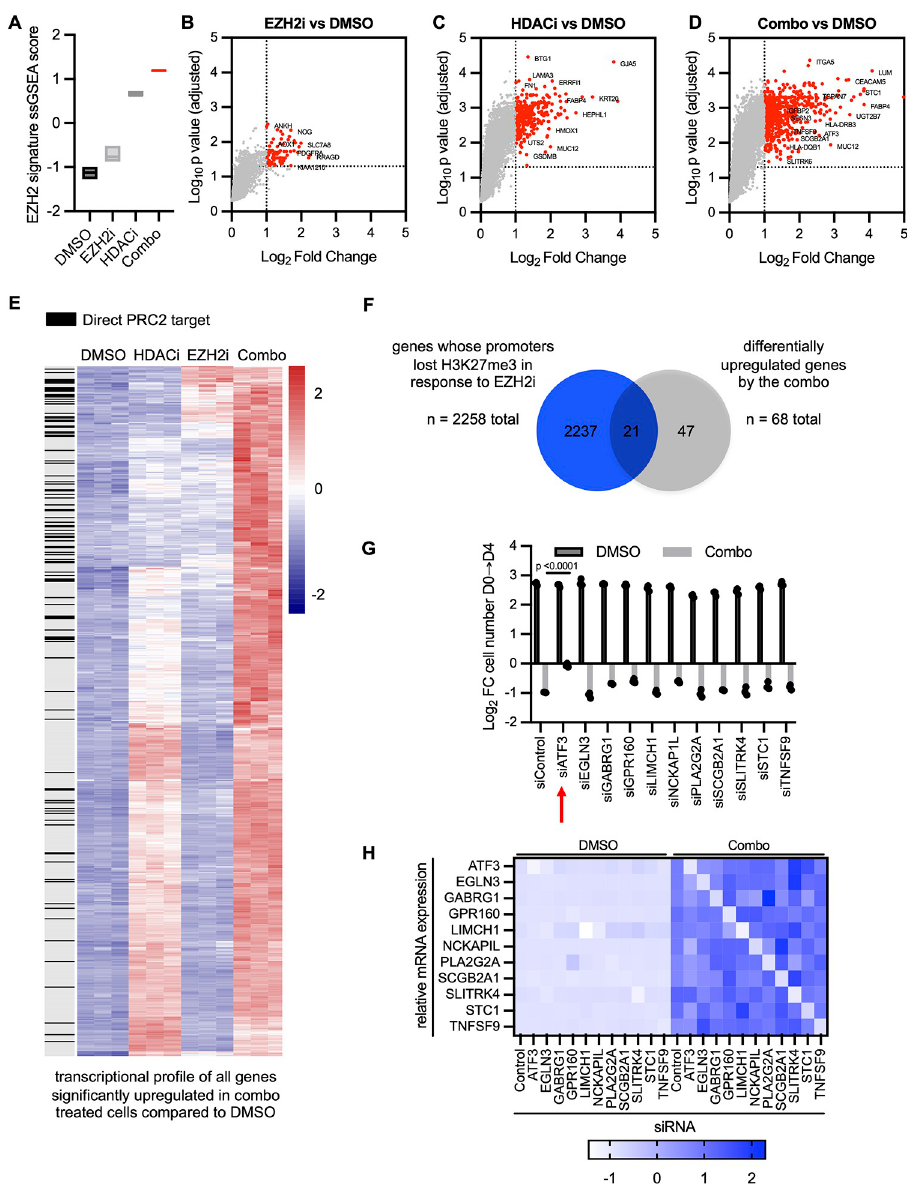
Fig 2. EZH2 and HDAC inhibitors cooperatively derepress a subset of PRC2 targets in CRPC. (A) Single sample GSEA of PC3 cells treated with DMSO, EZH2i, HDACi, or the combination. Box plot shows min to max of z scores with line at median for each treatment (S2 Data). ( B-D) Volcano plots depicting up-regulated genes in EZH2i vs. DMSO ( B ), HDACi vs. DMSO ( C ), or Combo vs. DMSO ( D ) samples (S2 Data). Each dot is one gene. Red dots are significantly differentially expressed genes (log 2 fold change > 1, adjusted p -value < 0.05). ( E) Heatmap showing the transcriptional profile of all genes significantly up-regulated in combo-treated cells vs. DMSO (log 2 fold change > 1, adjusted p -value < 0.05). Each gene is annotated for whether it is a direct PRC2 target (gene whose promoter lost H3K27me3 in response to EZH2i). ( F) Venn diagram of potential PRC2 targets (e.g., genes whose promoters lost H3K27me3 in response to EZH2i) and genes differentially induced by the combination (significantly different genes in all 3 comparisons: Combo vs. DMSO, Combo vs. HDACi, Combo vs. EZH2i). ( G ) Bar graph depicting functional screen of top candidate genes identified in F . PC3 cells were transfected with the indicated siRNAs and then treated with DMSO or Combo. Relative cell counts are shown in relation to day 0 (S2 Data). Each value is reported as mean ± SD of 3 biologically independent samples. P value measured by unpaired one-tailed heteroscedastic Student t test. ( H) Heatmap confirming knockdown of targets in G . RT-qPCR analysis of indicated mRNAs was performed in response to the combination in PC3 cells transfected with the indicated siRNAs. EZH2, enhancer of zeste homologue 2; GSEA, gene set enrichment analysis; HDAC, histone deacetylase; PRC2, Polycomb Repressive Complex 2; RT- qPCR, quantitative reverse transcription